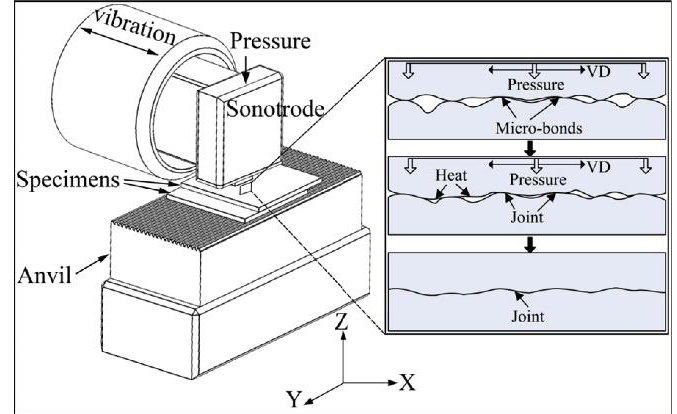
Figure 1. The principle of USW [23].